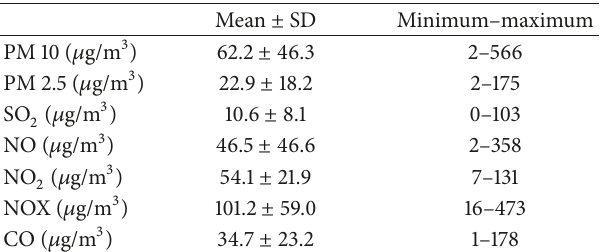
Table 2: Descriptive statistics for air pollution